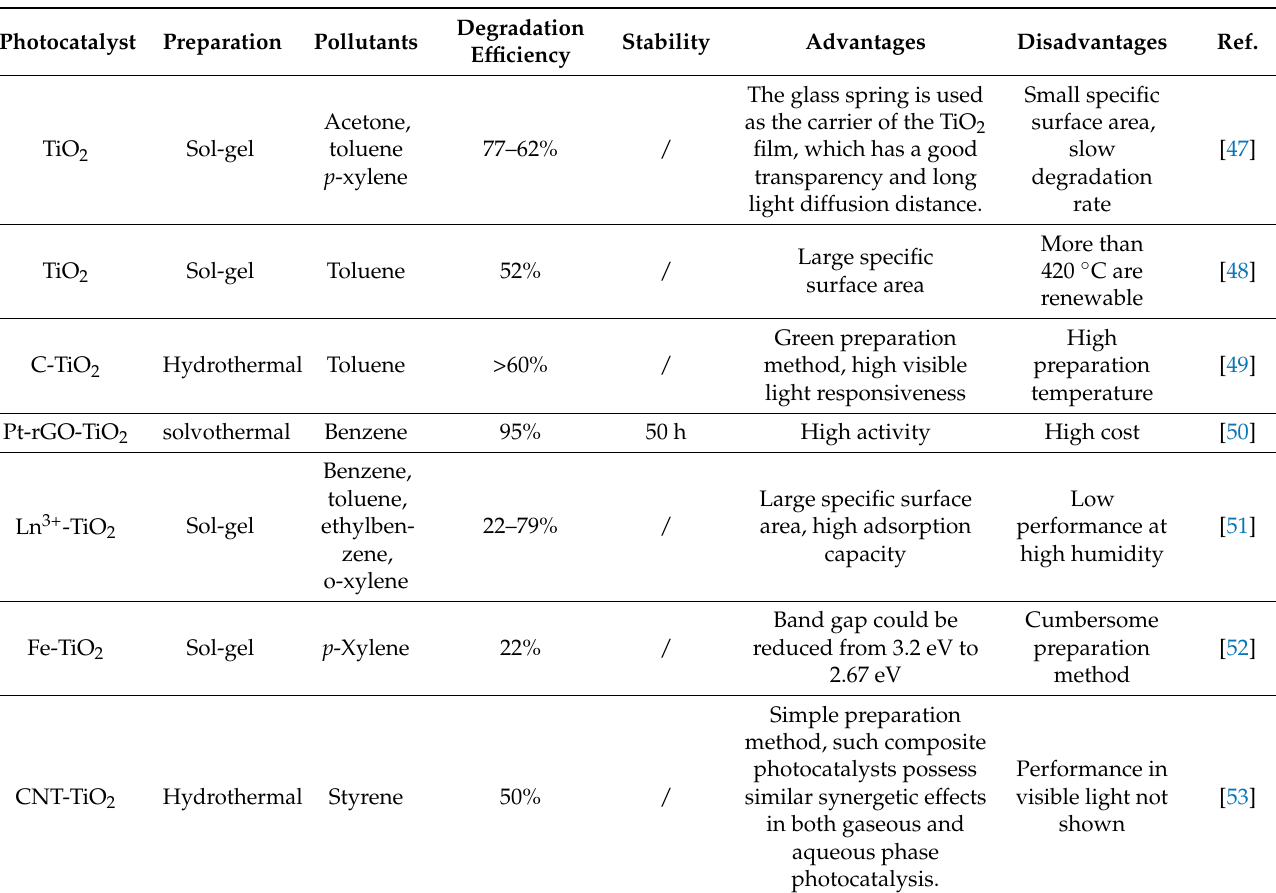
Table 1. TiO 2 -based materials for VOC